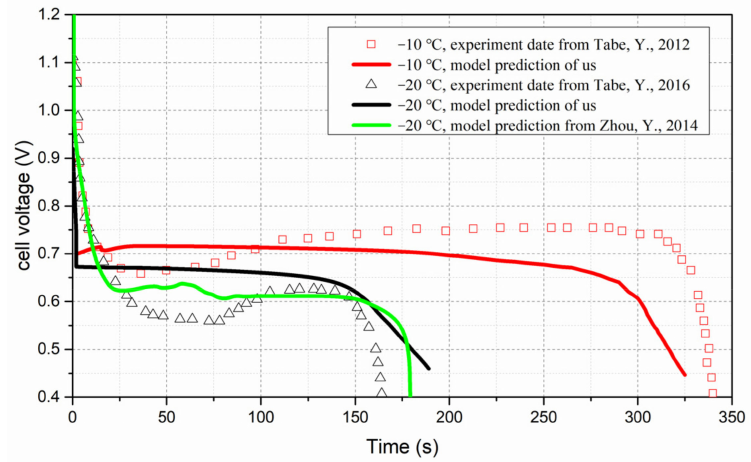
Figure 4. Cell voltage evolution by model prediction and by experiment, at − 10 ◦ C and − 20 ◦ C, 0.08 A/cm 2 [44,45,49].